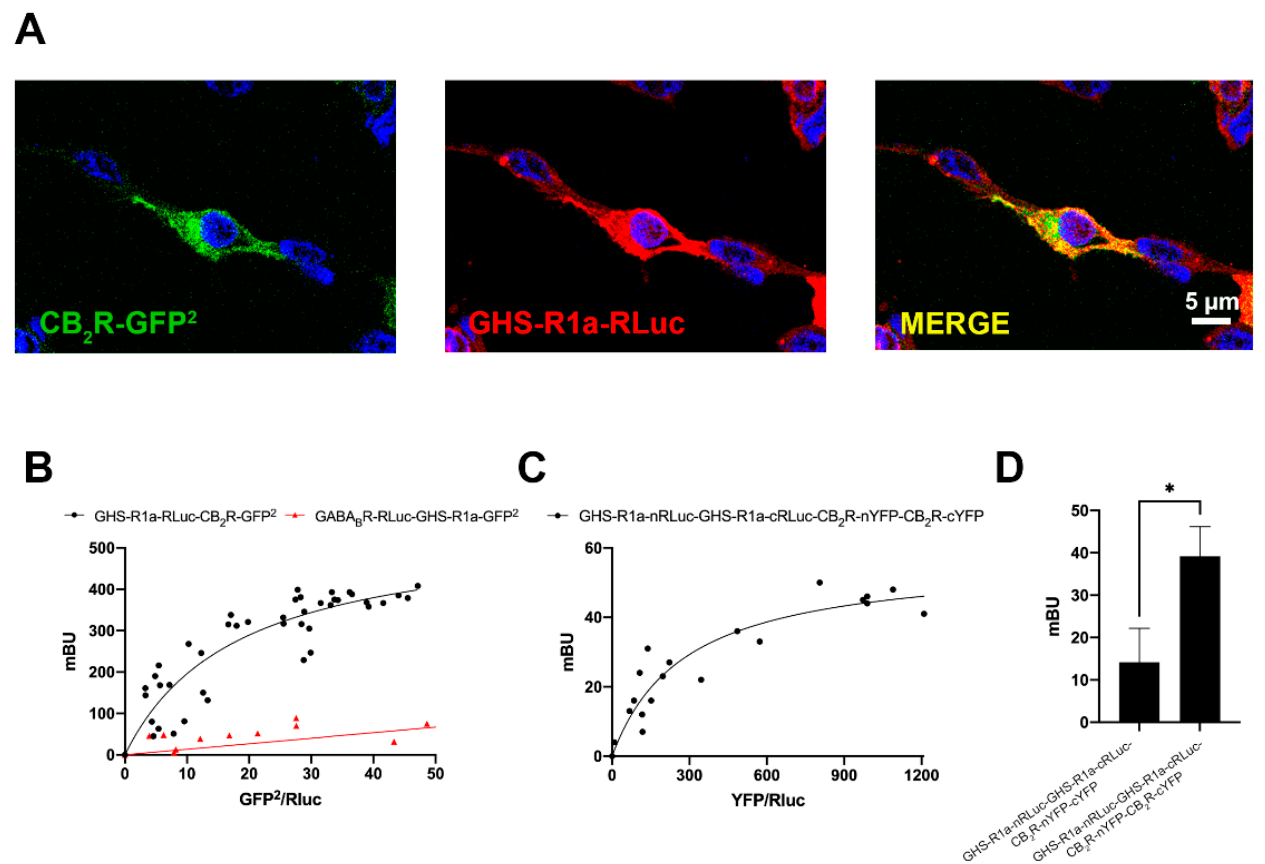
Figure 1. Molecular interaction between GHS1a and CB 2 receptors expressed in transfected HEK-293T cells. ( A ) Confocal microscopy images of HEK-293T cells co-transfected with cDNAs for GHSR1a-RLuc (0.75 µ g) and for CB 2 R-GFP 2 (0.5 µ g). GHSR1a-RLuc (red) was identified by immunocytochemistry using an anti-RLuc antibody (Merck-Millipore, 1/100). The CB 2 R-GFP 2 (green) was identified by the fluorescence due to GFP 2 . colocalization is shown in yellow (image in the right). Cell nuclei were stained with Hoechst (blue). Scale bar: 5 µ m. ( B ) BRET saturation experiments were performed using HEK-293T cells co-transfected with (i) a constant amount of GHSR1a-RLuc cDNA (1.5 µ g) and increasing amounts of CB 2 R-GFP 2 cDNA (0–2 µ g) or (ii) a constant amount of GABA B -RLuc cDNA (0.75 µ g) and increasing amounts of GHSR1a-GFP 2 cDNA (0–2 µ g) as negative control. BRET data are expressed as the mean ± SEM of 8 different experiments performed in duplicates. ( C ) Bimolecular luminescence and fluorescence complementation (BiLFC) assays were performed in HEK-293T cells co-transfected with a constant amount of GHSR1a-cRLuc and GHSR1a-nRLuc cDNAs (1.5 µ g each) and increasing amounts of CB 2 R-cYFP and CB 2 R-nYFP cDNAs (0–3 µ g each). ( D ) HEK-293T cells were co-transfected with 1.5 µ g of the GHSR1a-cRLuc and GHSR1a-nRLuc cDNAs and 3 µ g of the CB 2 R-nYFP and CB 2 R-cYFP cDNAs or with the non-fused cYFP as negative control. BRET data are expressed as the mean ± SEM of 7 different experiments performed in duplicates. * p < 0.05. mBU: milliBret